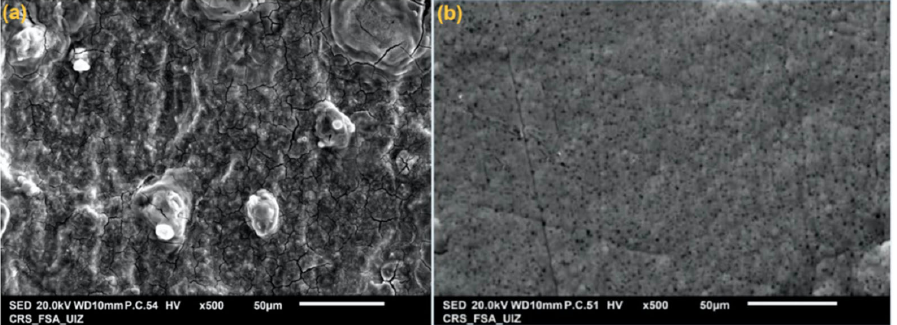
Figure 2. SEM photograph of mild steel specimen in the ( a ) absence and ( b ) presence of HYD-1 corrosion inhibitor (Chaouiki et al., 2020) [38].